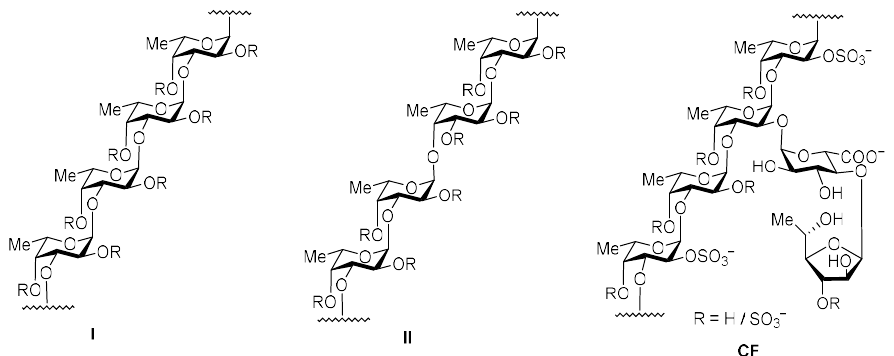
Figure 3. Two types of homofucose backbone chains in brown seaweed fucoidans ( R depicts the places of potential attachment of carbohydrate substituents, sulfate, and acetyl groups) and the structure of fucoidan CF from C. flagelliformis seaweed.